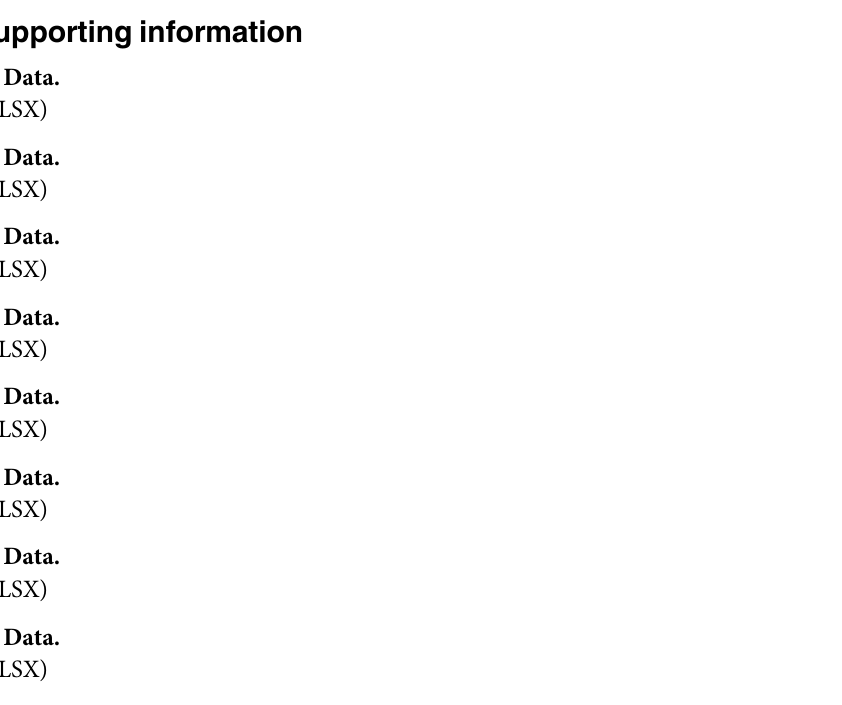
S1 Fig. Morphological analysis by phase contrast light microscopy. (A) CES were stored for 20 days then re-incubated for 3 and 5 days (magnification: 400X). White arrowhead : vacuoles. Black arrows : gap in cell layer. Black arrowhead : detaching/apoptotic cell. (B) CES stored for 15 days in the incubator in either a sealed dish with MEM storage medium (left; magnification: 40X) or with CnT-Prime medium that was exchanged every 2 days (right; magnification: 100X). (C) The graph shows the percentage of apoptotic cells and stressed cells containing vac- uoles. Cells were characterized and quantified using 400X magnification photographs (n =